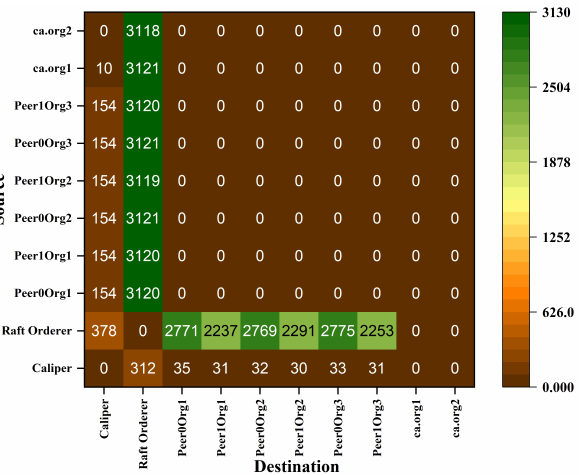
Figure 11. Heatmap of Transaction Traffic Gossip for Proposed Framework (RAFT).